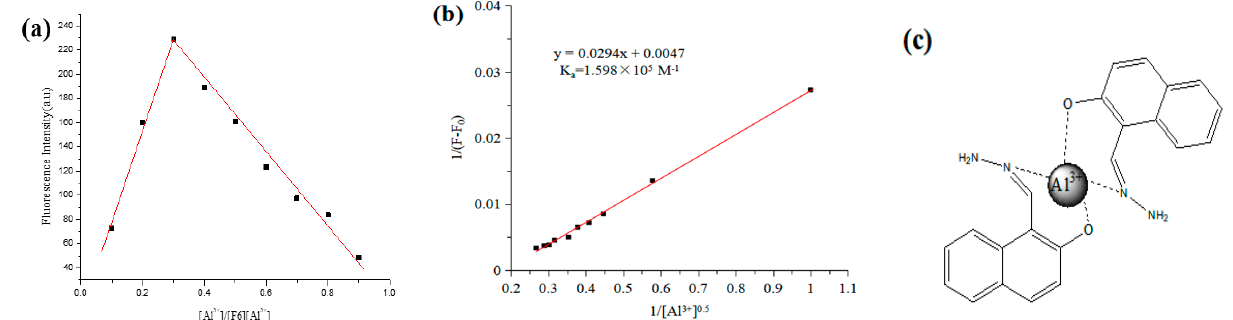
Figure 7. ( a ) The binding ratio of F6 to Al 3+ ; ( b ) Benesi–Hildebrand plot of probe F6 with Al 3+ ; ( c ) The possible binding mechanism of probe F6 to Al 3+ .